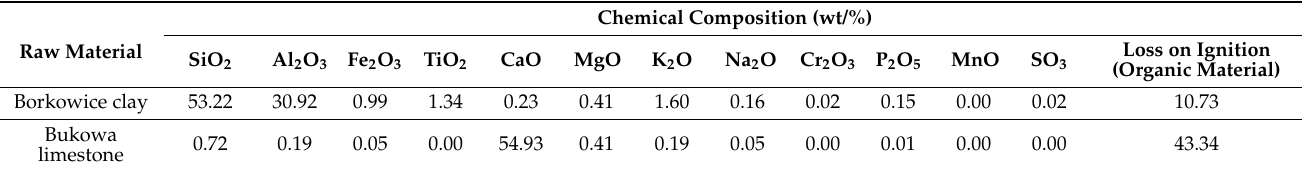
Table 1. Chemical analysis of raw materials: Borkowice clay and Bukowa limestone.